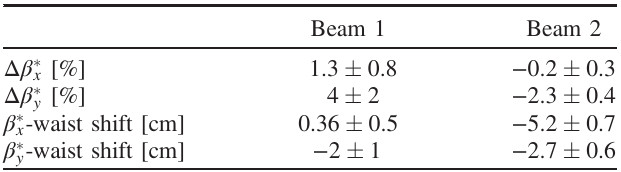
TABLE VII. Distortion of β (cid:1) and β (cid:1) -waist shift measurements in IR1 (ATLAS) due to orbit leakage during K-modulation. Measurements are for the operational configuration of the β (cid:1) ¼ 0 . 3 m optics. Values quoted are the relative change in β (cid:1) , and the shift to β (cid:1) -waist, between K-modulation measurements per- formed with and without the orbit feedback active.